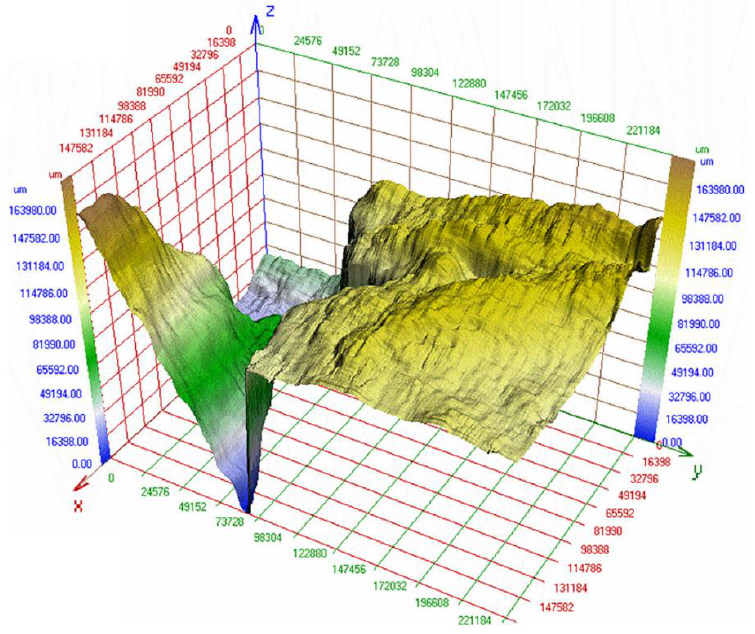
Figure 5. 3D reconstruction of the data from Figure 3 after elementary registration by Figure 4a. Reconstruction taken from [27]. Software developed by the author.